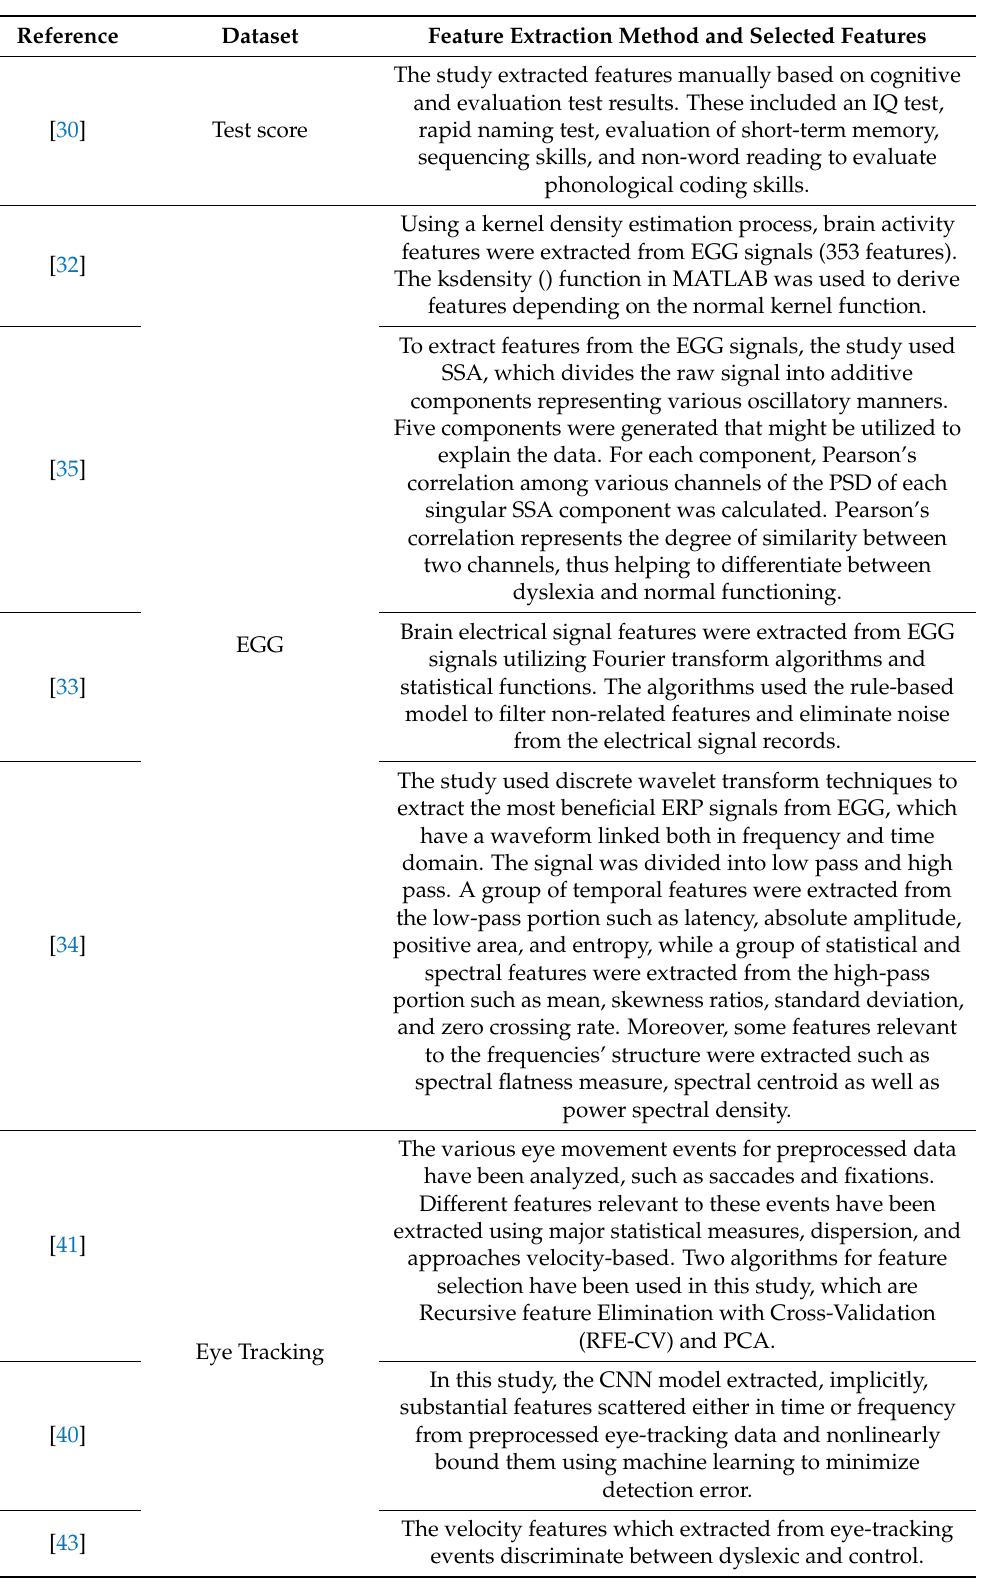
Table 2. Feature extraction methods for dyslexia disorder detection utilizing Deep Learning